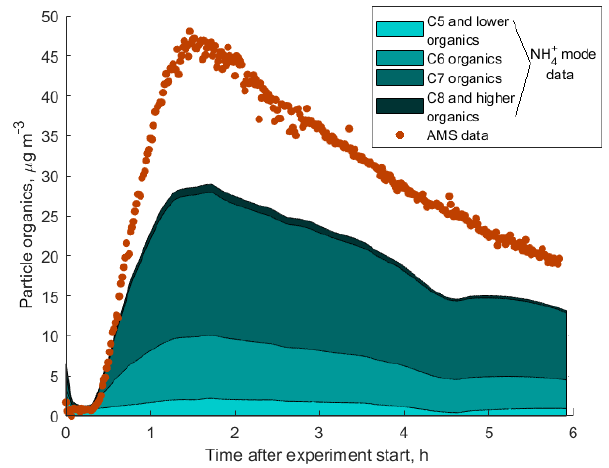
Figure 8. SOA produced during photooxidation of 3- methylcatechol in a laboratory experiment. The total organic aerosol mass is measured by an AMS. OVOCs detected by NH 4 CIMS are binned in four